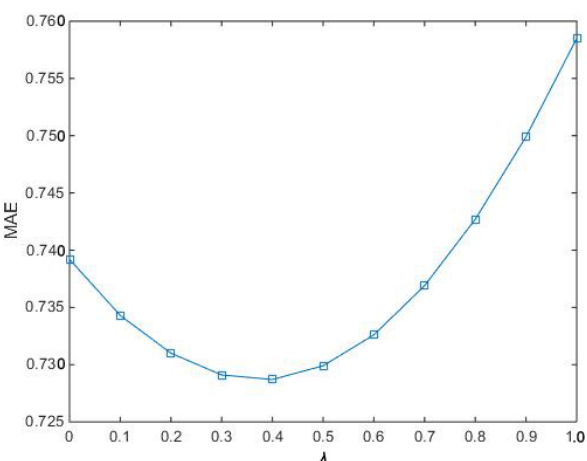
Fig. 3 Effect of parameter (cid:21) on MAE by the TT-HybridCF algorithm.